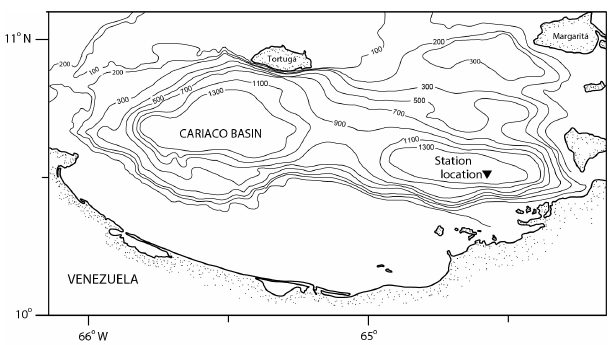
Figure 1. Bathymetric map of the Cariaco Basin. The location of the sediment trap (10 ◦ 30.0 (cid:48) N, 64 ◦ 38.5 (cid:48) W) is marked with a triangle (modified from Marshall et al.,